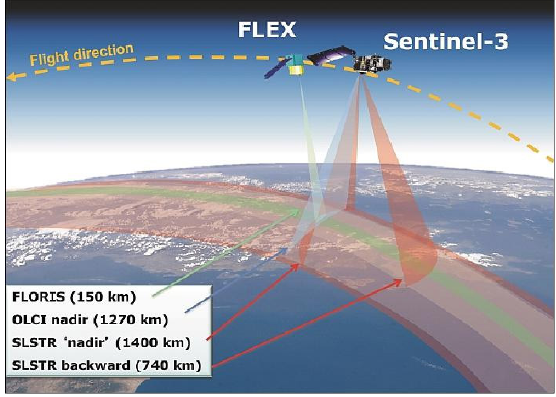
Figure 6. FLEX and Sentinel-3 joining forces (image